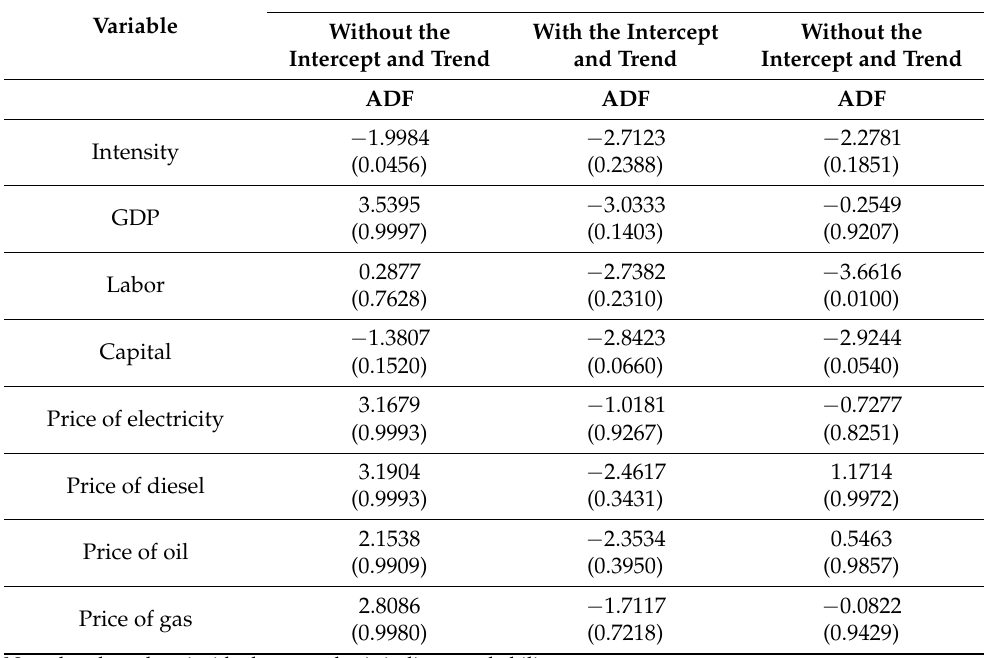
Table 2. The initial ADF test results.